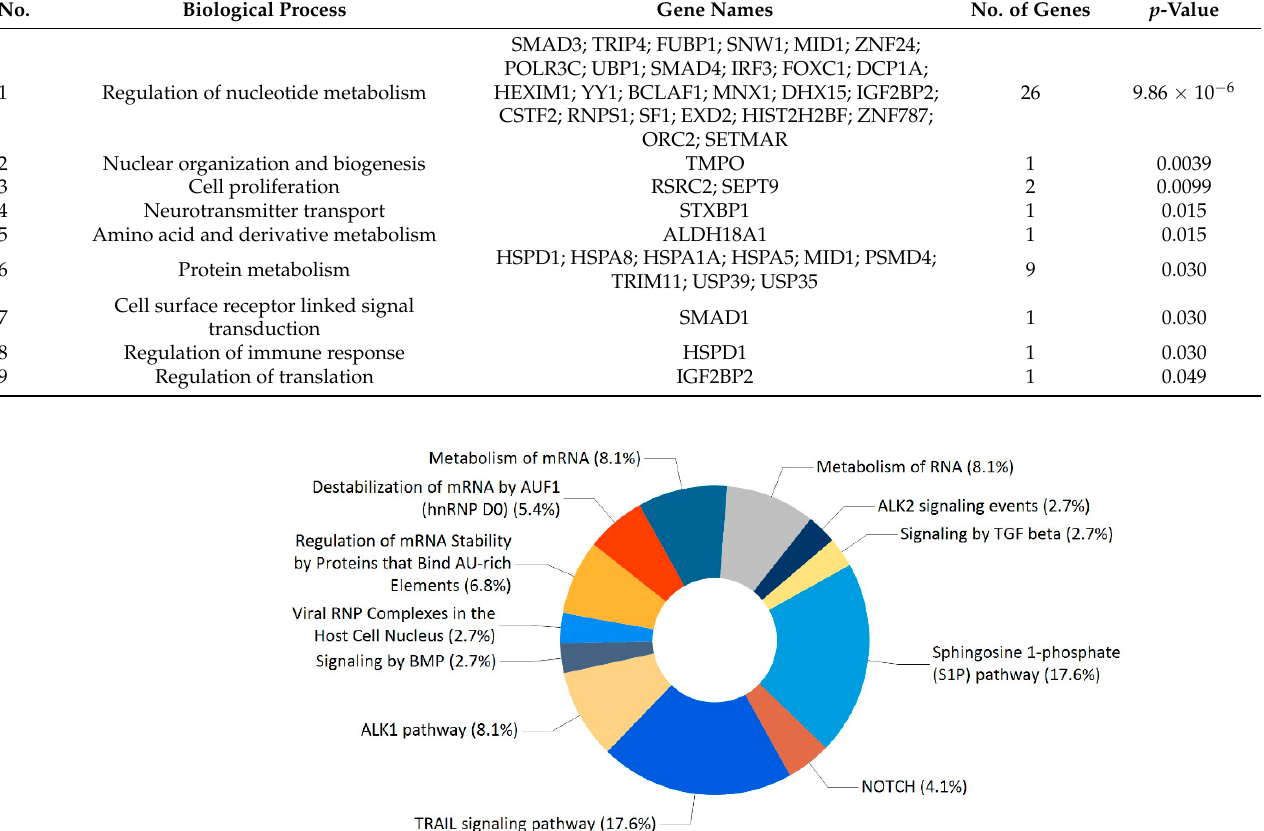
Table 2. Classifications of biological processes in relation to the PACRG interaction partners. S. No.